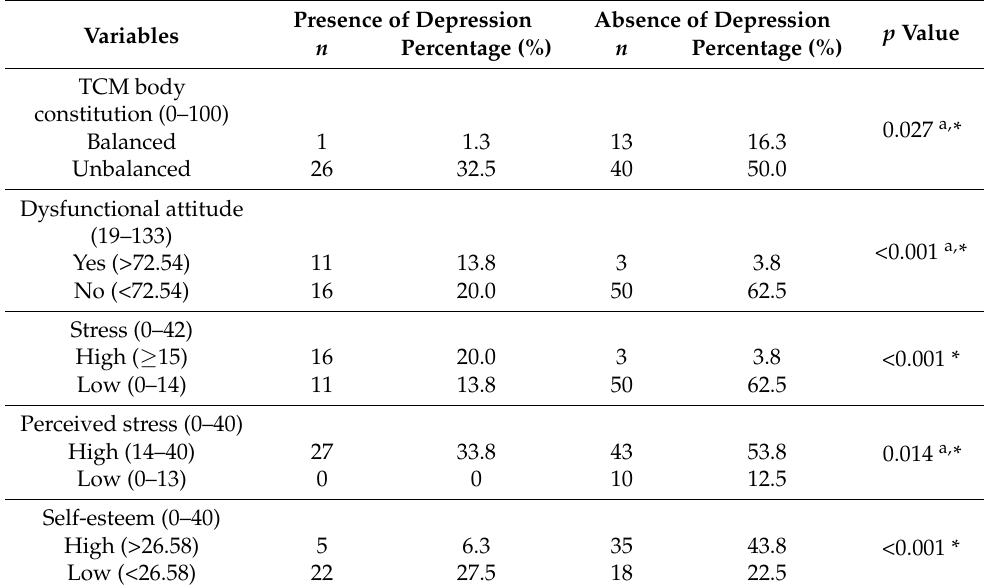
Table 3. Associations of traditional Chinese medicine body constitutions, dysfunctional attitude, stress, perceived stress, and self-esteem with